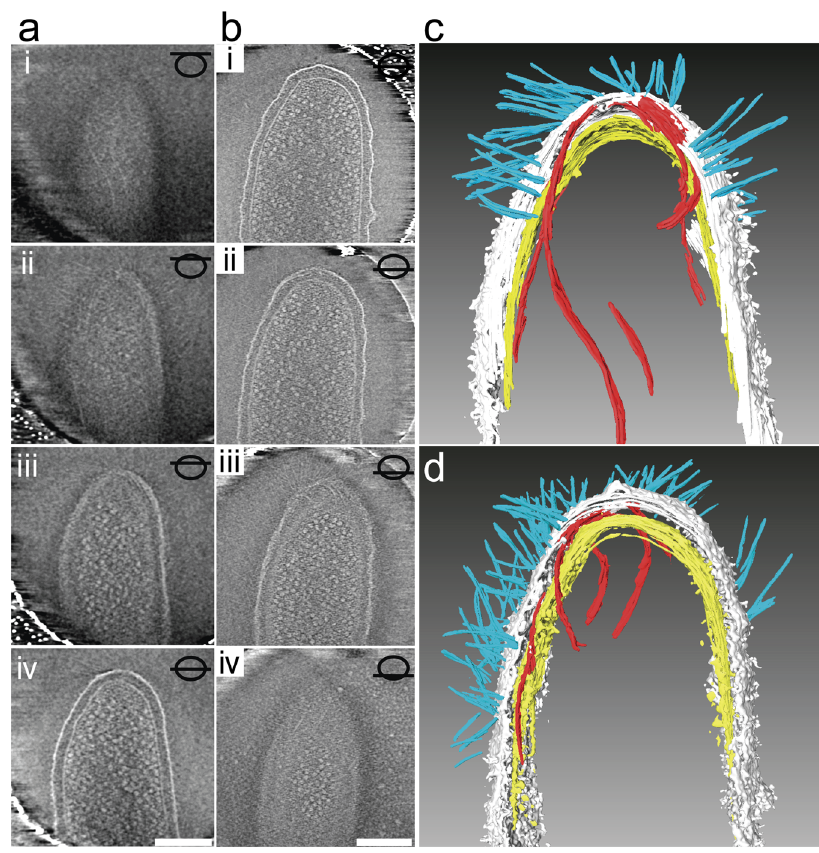
Fig. 4 Cryo-electron tomography of wild-type F. johnsoniae cells. Section images were taken from two representatives of 3D reconstructions of plunge- frozen wild-type cells ( a , b ). A schematic drawing with a slice position (inset) corresponds to each Z-slice image (i to iv in a and b ). Bars indicate 200 nm. 3D segmentation images of tomograms shown in ( a , b ) ( c , d , respectively) denote long thin electron-dense structures (red), SprB fi lament (cyan), peptidoglycan layer (yellow), and outer membrane (light gray).